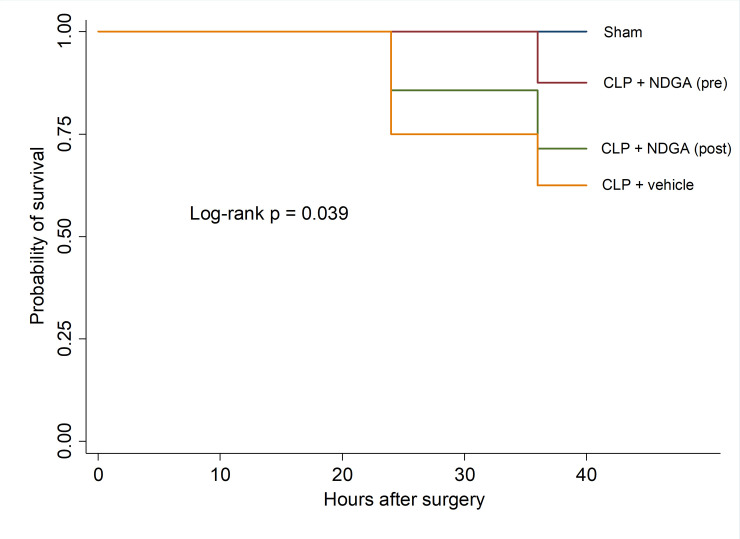
36 hour survival rate among all groups.A significant improvement in mortality is seen when a single dose of NDGA is given either at the time of induction of CLP or 6 hours after induction of CLP (n = 8 in each group).